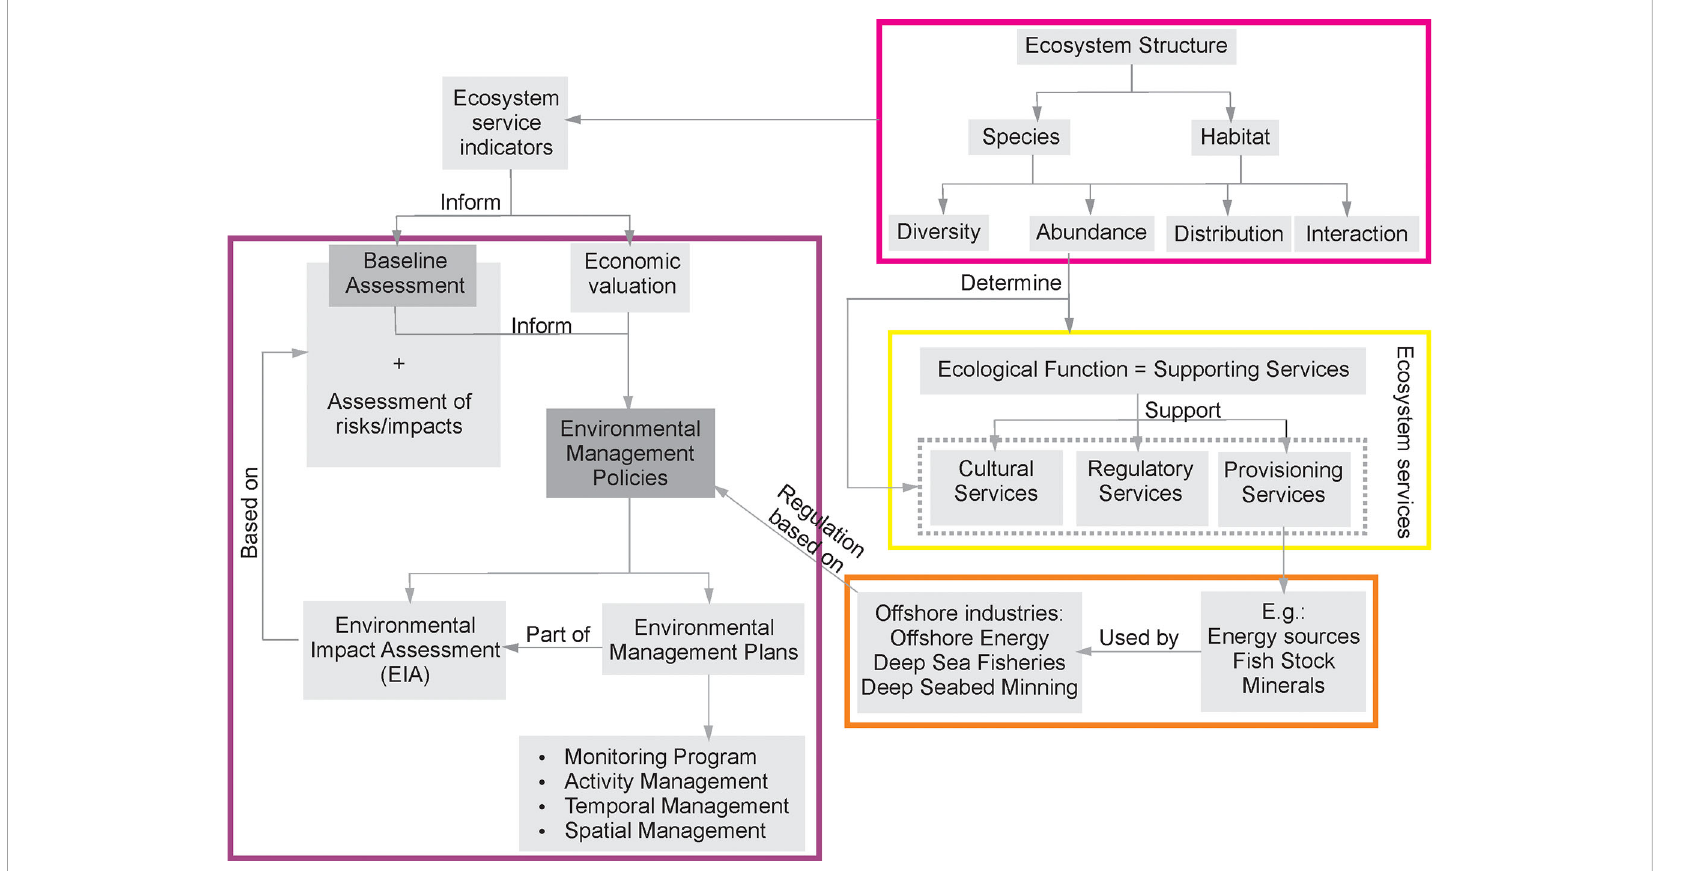
FIGURE 4 Environmental management of offshore industries in the frame of ecosystem